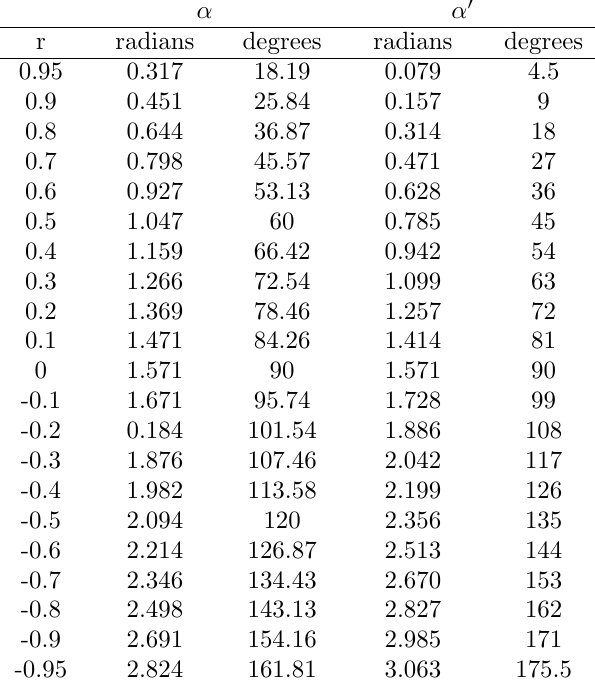
Relation of the correlation coefficient r to the angle (cid:11) given by formula (2) and to the angle (cid:11) ′ given by formula (4) (cid:11) (cid:11)